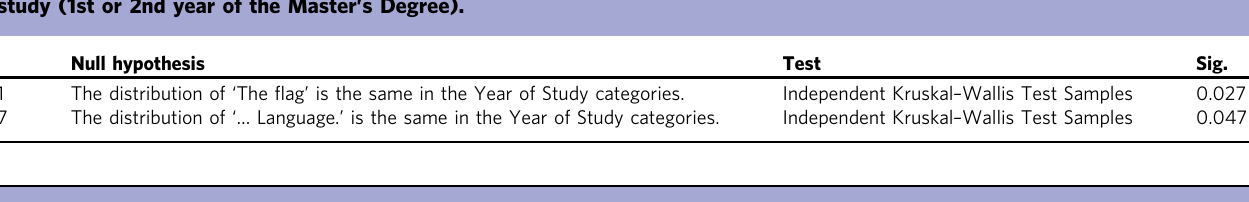
Table 12 Contingency table with the description of the rank score for the identity symbol “ Bandeira – Flag ” according to the study year of the Master ’ s Degree students.